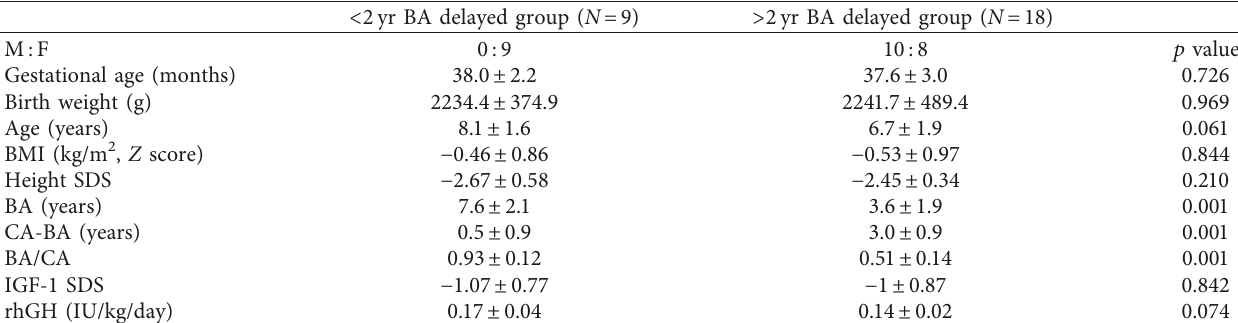
Table 3: Initial clinical and laboratory characteristics when classified according to whether patients had bone age (BA) delay of more or less than 2 years.